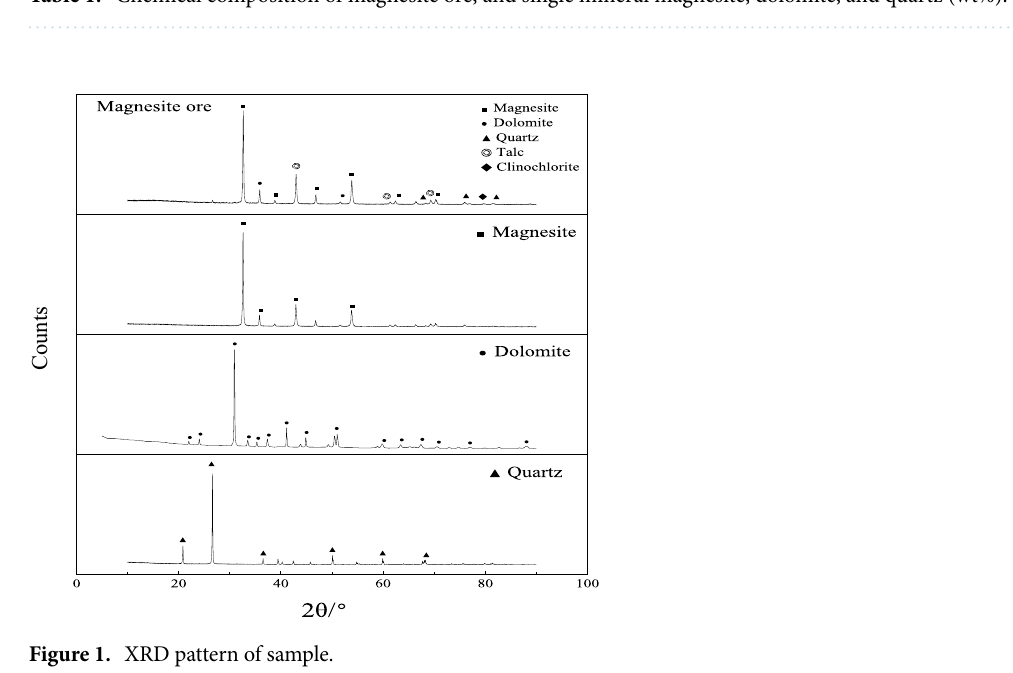
Table 1. Chemical composition of magnesite ore, and single mineral magnesite, dolomite, and quartz (wt%).